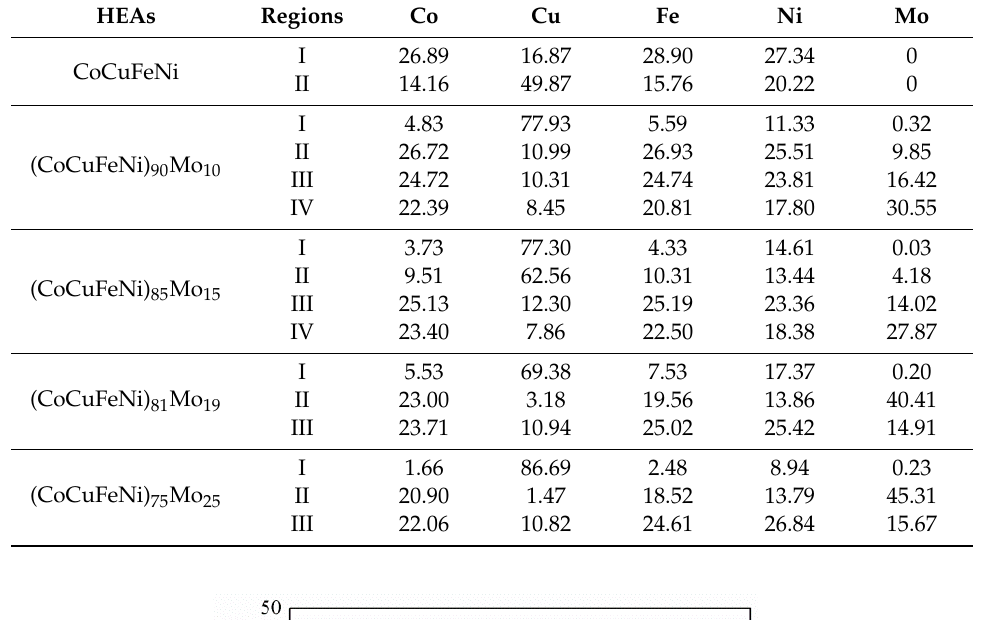
Table 1. Chemical compositions (in at.%) of various regions in (CoCuFeNi) 100- x Mo x high entropy alloys. HEAs Regions